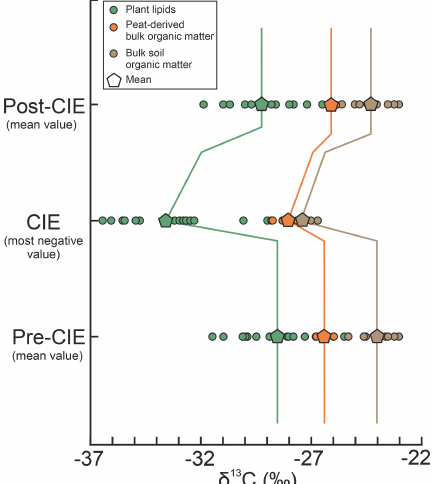
Figure 4. Comparison of terrestrial carbon isotope excursions (CIE). Data from plant-derived lipids (yellow) and soil organic mat- ter (green) are from McInerney and Wing (2011). Data from peat- derived bulk organic matter are compiled from new (this study) and published studies (Collinson et al., 2003; Inglis et al., 2015; Storme et al., 2012). Whereas the pre- and post-CIE values represent mean δ 13 C values, the CIE is given as the most negative values, following McInerney and Wing